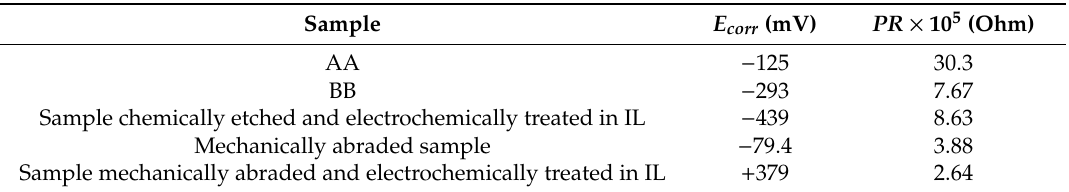
Table 2. Corrosion potentials ( E corr ) and polarization resistances ( PR ) for the electrochemical oxidation of the samples of the Fe70Cr15B15 amorphous alloy in the 0.1 M Na 2 SO 4 aqueous solution (295